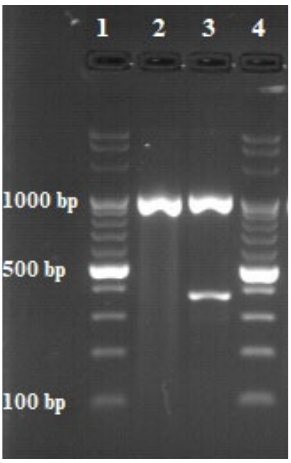
Figure 3. Results of multiplex PCR. 1 and 4—DNA ladder (100 bp); 2—sample; 3—positive control ( M. bovis DNA) .